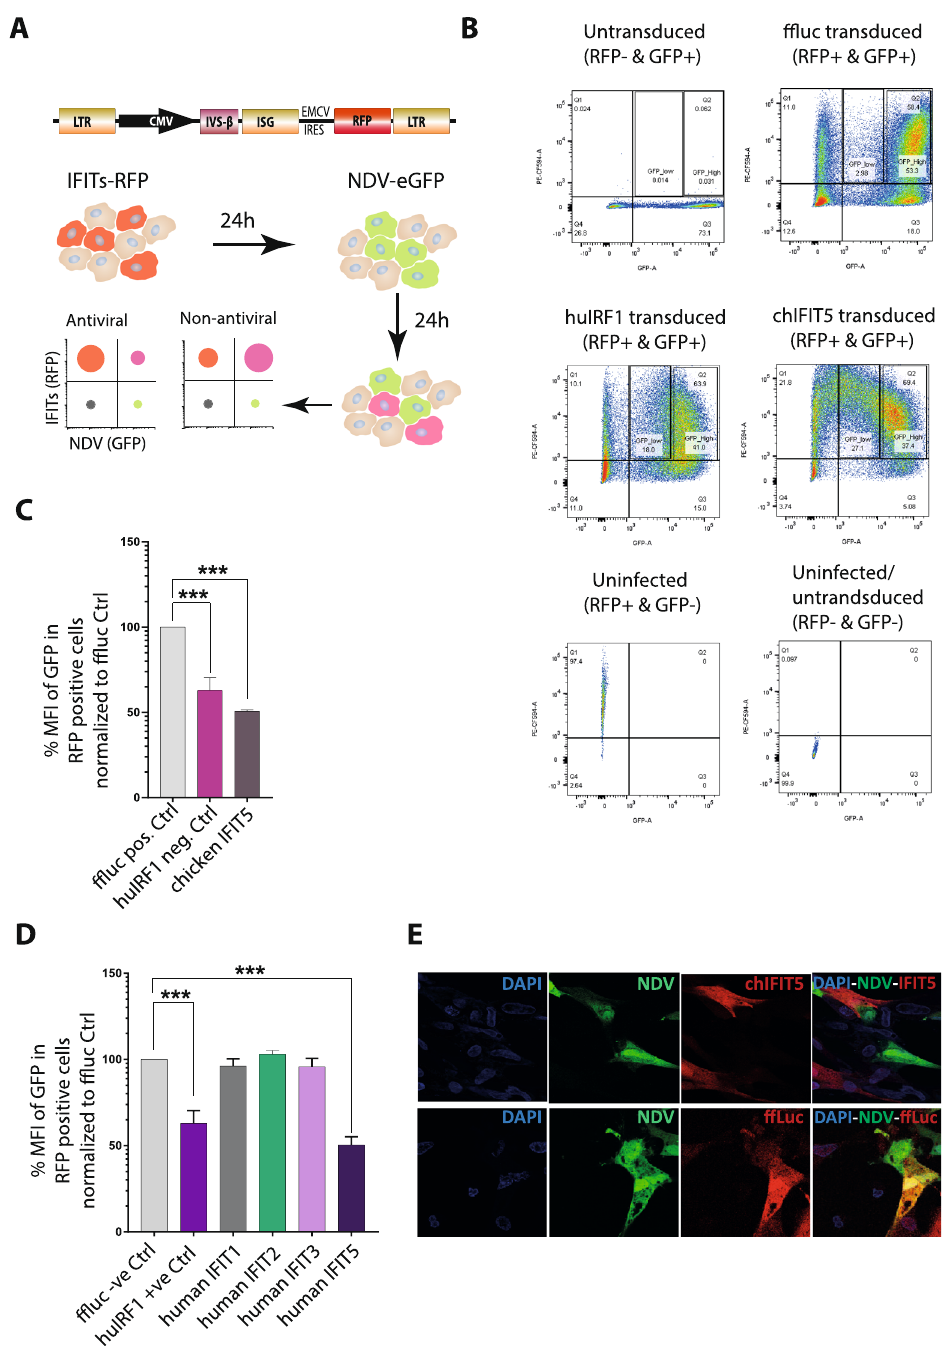
Figure 5. Stable overexpression of different IFIT proteins and their antiviral potential against NDV replication. ( A ) Lentiviruses bicistronically expressing the chIFIT5, huIRF1 or firefly luciferase (ffluc) along with RFP marker gene were transduced into the CEFs for 24 hours. These individual gene-expressing cell populations were then infected with NDV-GFP for another 24 hours before analysis using FACS. In the event of antiviral activities of the transgene, the percentage of GFP positivity would be reduced compared to ffluc control. ( B ) Cells were gated in untransduced (GFP + and RFP − ), uninfected (RFP + and GFP − ) or untransduced and uninfected (RFP- and GFP − ) quadrants. Cells expressing ffluc, huIRF1 and chIFIT5 were then gated to each of these quadrants for GFP + in RFP + cell population. For demonstration purposes, GFP + cell population was further divided into low GFP + and high GFP + cells indicating corresponding NDV replication. ( C ) Cumulative mean fluorescent intensity (MFI) of 5 independent experiments presented in section B showed significant inhibition of NDV in both huIRF1 and chIFIT5-transduced cells compared to ffluc control. ( D ) Similar to section B, cells were transduced with huIFIT1, huIFIT2, huIFIT3 and huIFIT5, and gated accordingly. Cumulative data of 3 independent experiments indicated a significant inhibition of virus replication in huIRF1 and huIFIT5 expressing cells. ( E ) CEFs were transduced with lentiviruses expressing ffluc or chIFIT5 and were infected with NDV-GFP. Individual cells co-expressing GFP and RFP were